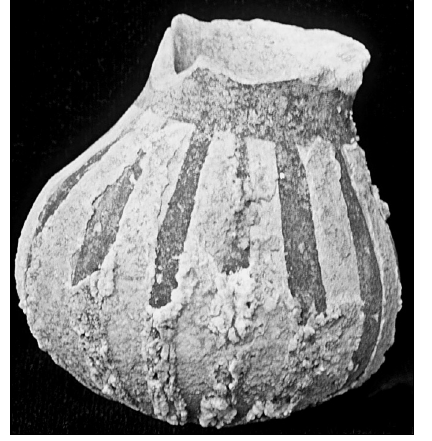
Figure 6 A painted Ubaid pottery jar from the H3 Site, partially encrusted with salts ( c. 7cm in diameter).